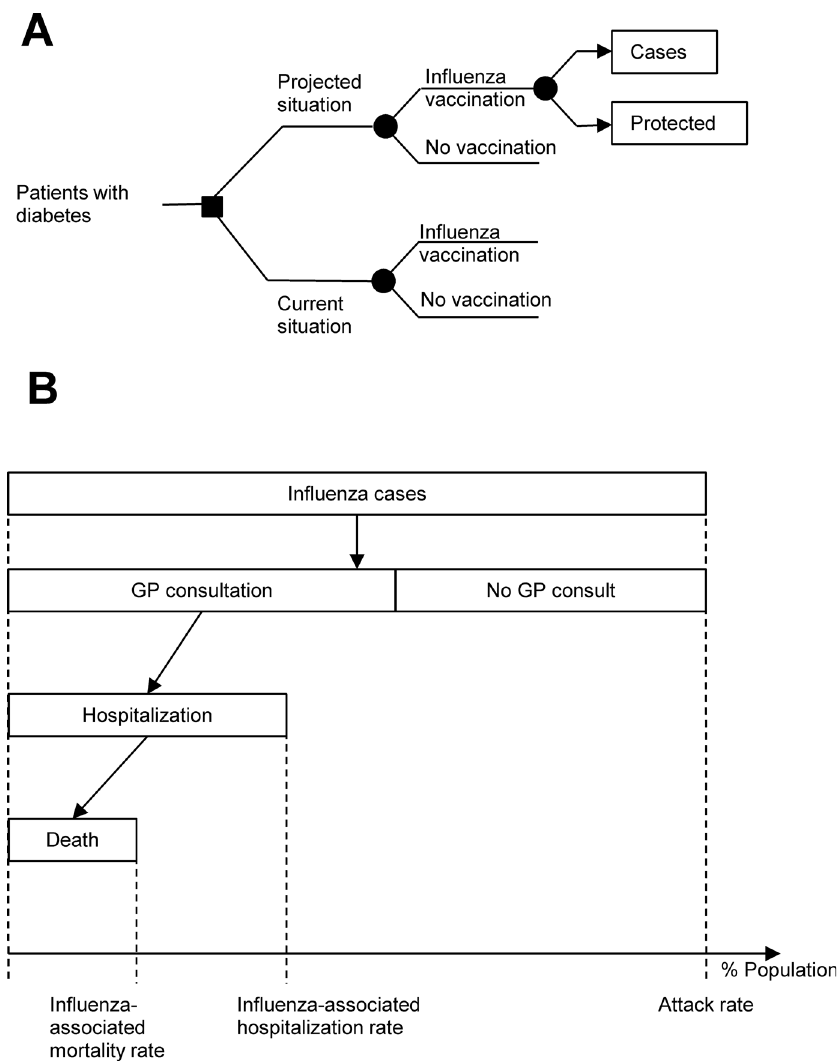
Fig 1. Model structure. (A) Decision tree of patients with diabetes. The projected situation differs from the actual situation only in higher vaccination coverage. Each year, vaccinated and unvaccinated patients with diabetes in both situations have a specific risk of being infected by influenza, which depends on the attack rate and the vaccine effectiveness for those vaccinated. Decision nodes are indicated with squares, and chance nodes are indicated with circles. (B) Resource utilization pathway. GP, general